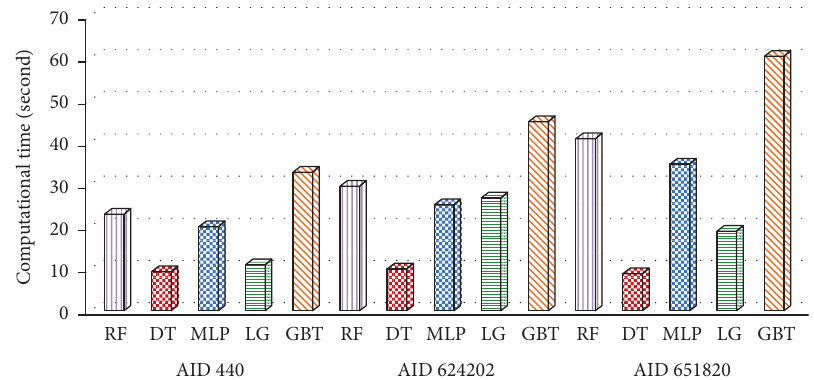
Figure 11: Comparison of computational time (seconds) in KSMOTE for the numeric PaDEL descriptor.